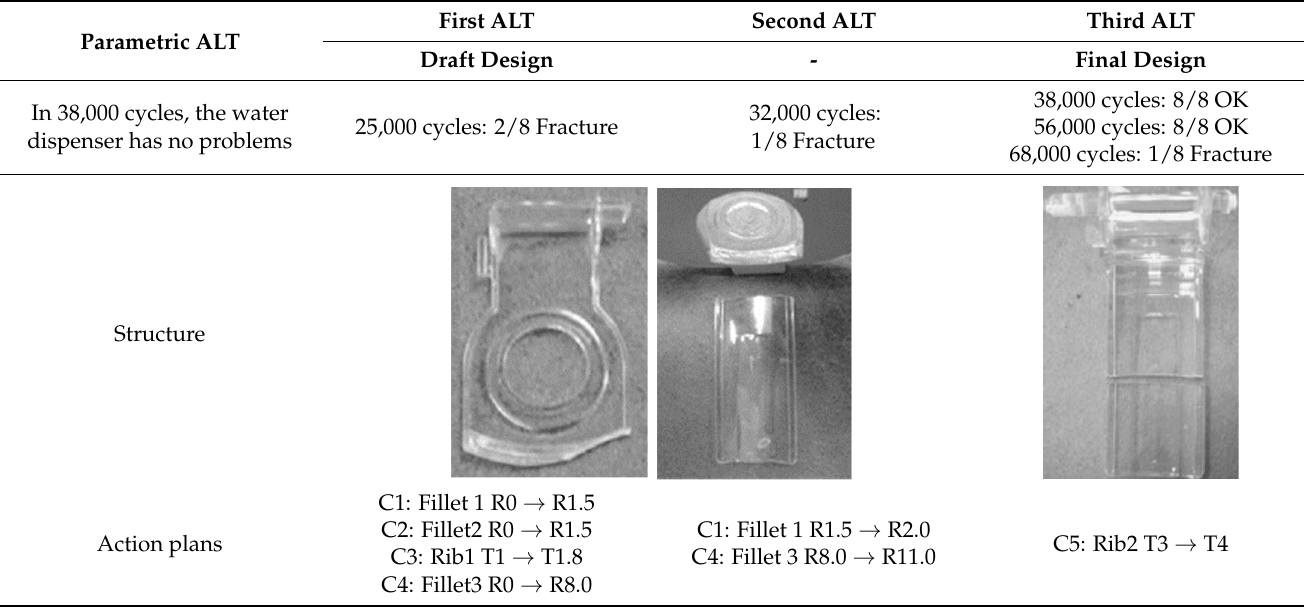
Table 4. The abridged consequence of parametric ALTs.